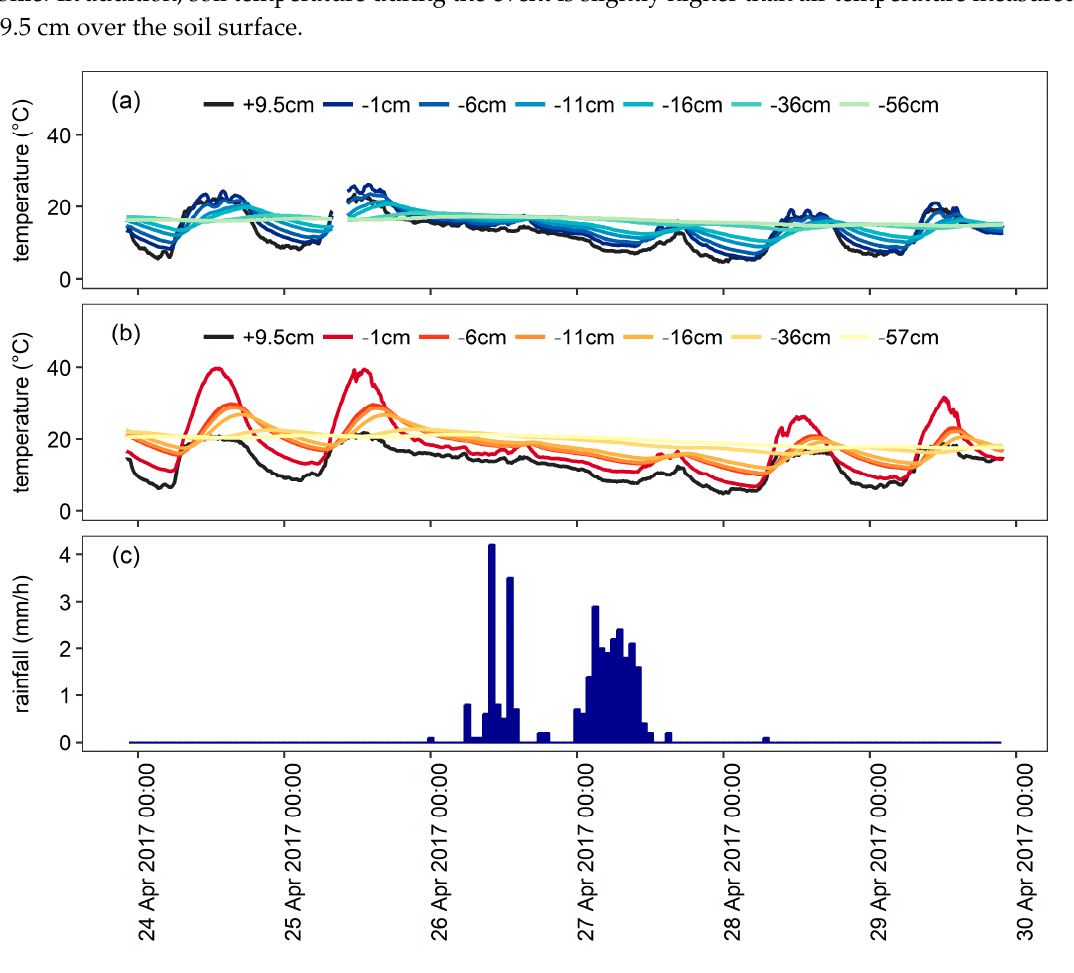
Figure 11. Air and soil temperature registered at the North (N) and South (S) slopes without vegetation during a rainstorm in April 2017. ( a ) Temperature data at the North slope; ( b ) temperature data at the South slope; ( c ) hourly rainfall. South slope; ( c ) hourly